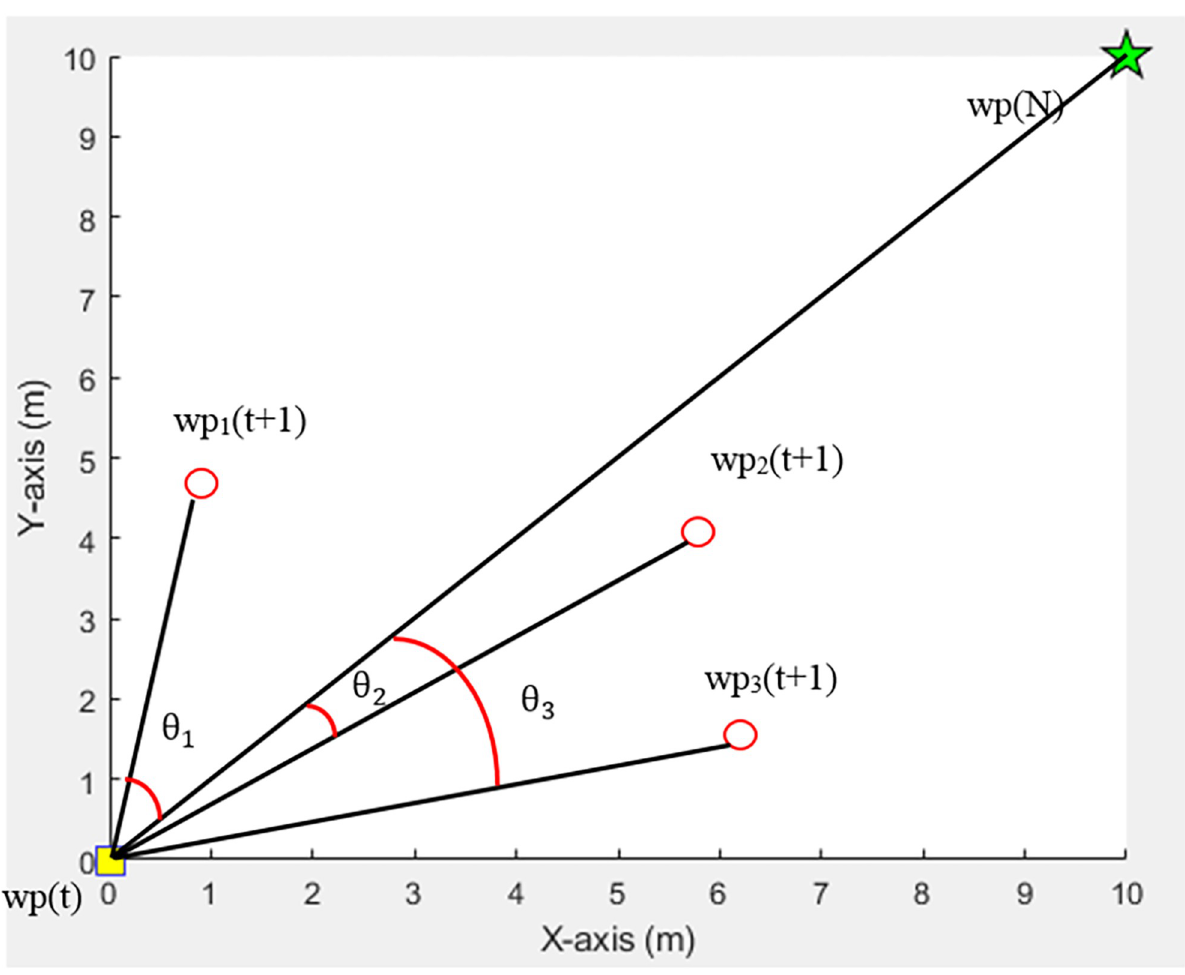
Fig 6. Consideration of smooth